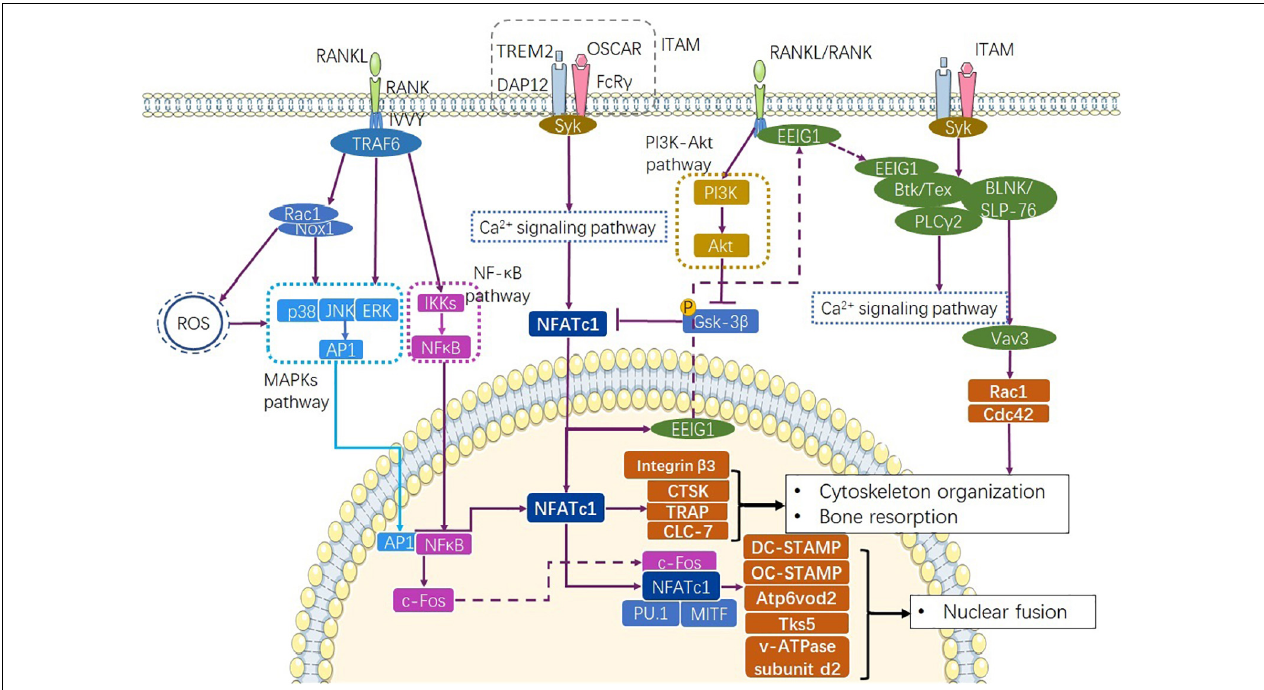
FIGURE 1 | Pathways involve in physiological osteoclastogenesis. RANKL/RANK complex recruits TRAF6 to express AP1 through MAPKs and NF- κ B through NF- κ B signaling pathway (Gyori and Mocsai, 2020). At the same time, Ca 2 + signaling pathway mediated by ITAM signaling promotes transcription of NFATc1 as well as the production osteoclastogenic factors CTSK, TRAP, and CLC-7. RANKL/RANK and ITAM signaling together complete the differentiation progress though the Ca 2 + signaling pathway (Park et al., 2017). RANKL/RANK also enhance NFATc1 via inhibiting GSK-3 β (Shin et al., 2014). ITAM, immunoreceptor tyrosine-based activation